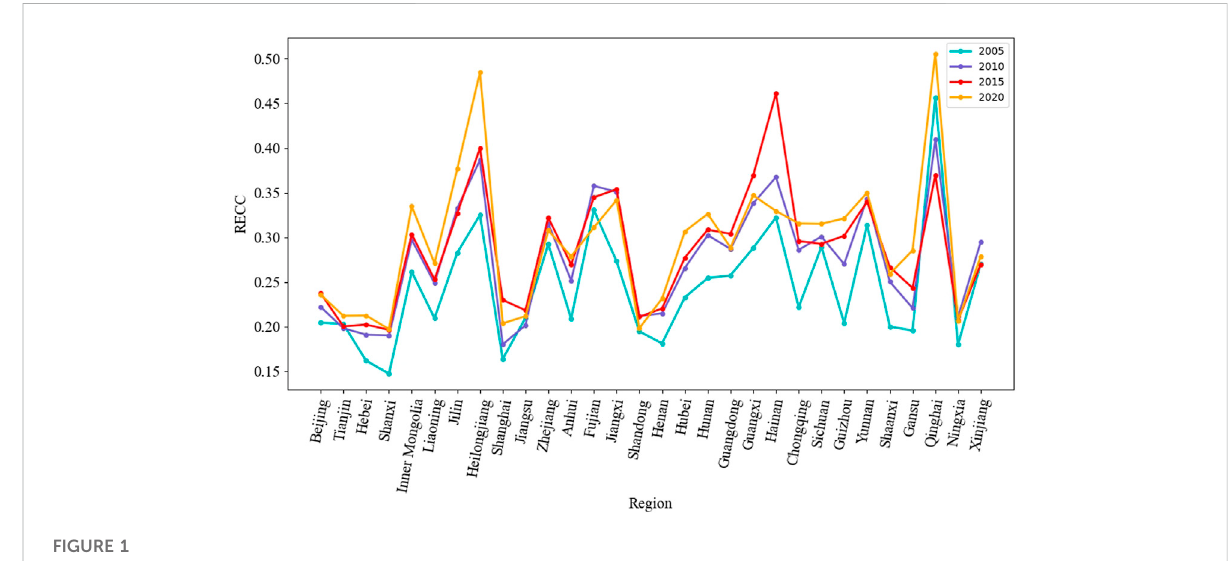
FIGURE 1 RECC temporal line chart of 30 provinces.